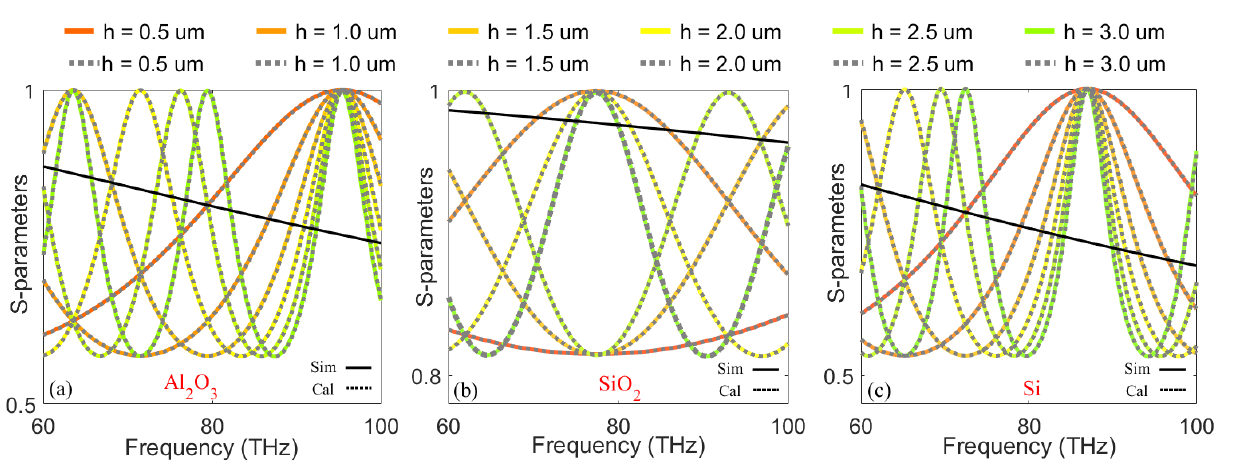
Figure 2. Cascade response when only transparent substrate is contained on 60–100 THz band, wherein the black curve is the case with a thickness of 0.1 um, that is, the cascade benchmark. ( a ) Al 2 O 3 ; ( b ) SiO 2 ; ( c ) Si.